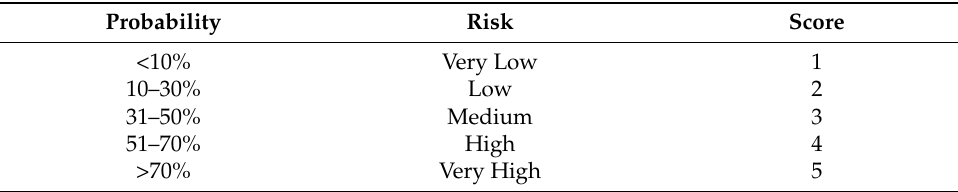
Table 2. Specifications of the mortality risk prediction